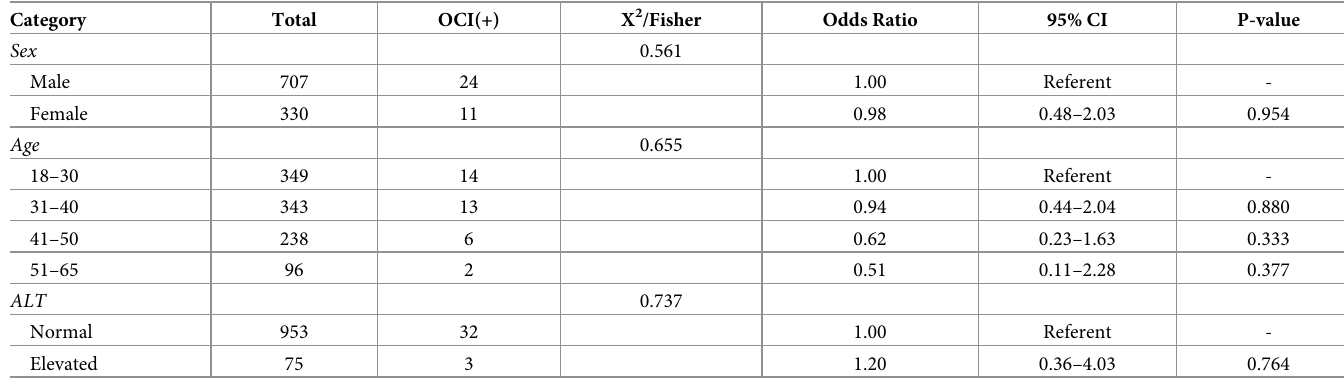
Table 1. Characteristics of the study